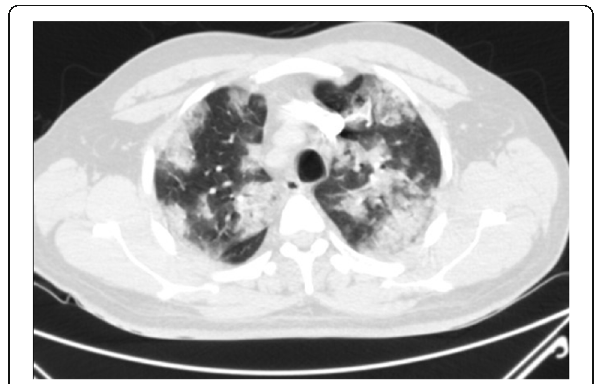
Fig. 3 Diffuse alveolar damage: thin section CT shows patchy areas of GGO and consolidation in the lung periphery in upper lobes